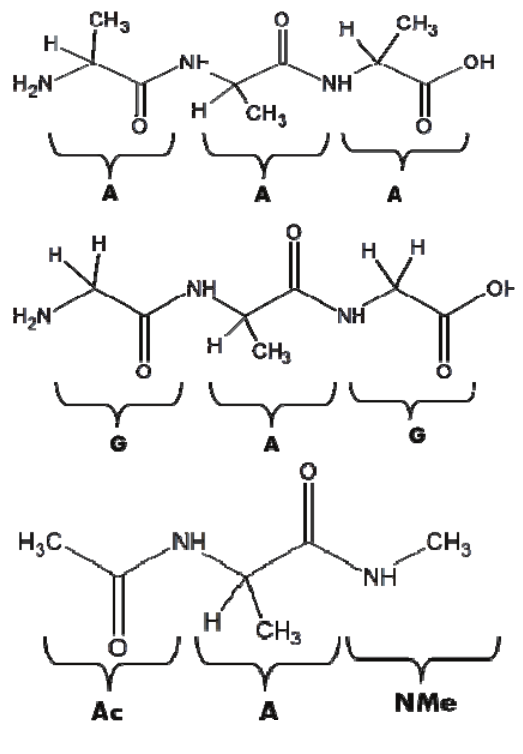
Figure 9. Unblocked AAA ( upper ), AdP ( middle ), and unlocked GAG peptide ( lower panel